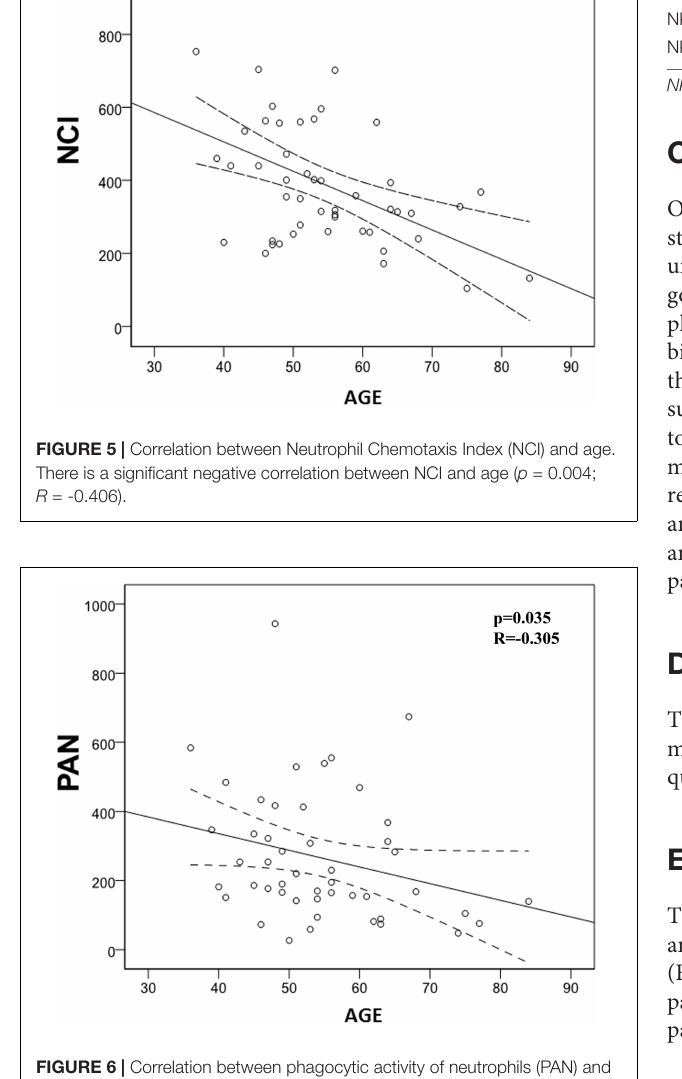
TABLE 8 | Correlation between stress and NK activity in both genders.